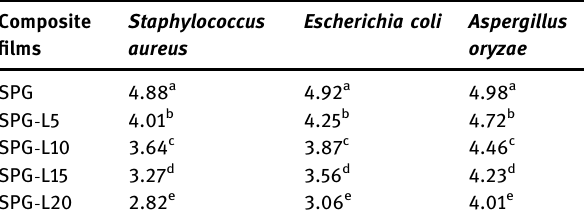
Table 4: E ff ect of ε - polylysine on viable count ( log CFU cm − 2 ) of composite fi lms Composite fi